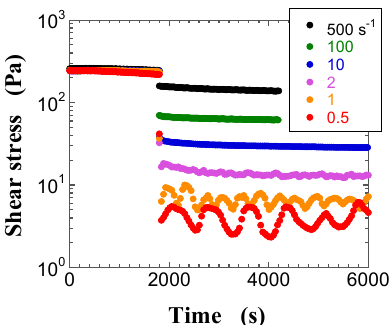
Figure 4. Plots of the transient shear stress for the precipitated silica (PS) suspension at φ = 0.030 at the shear rates of 0.5 s − 1 (filled red circle), 1 s − 1 (filled orange circle), 2 s − 1 (filled purple circle), 10 s − 1 (filled blue circle), 100 s − 1 (filled green circle), and 500 s − 1 (filled black circle) as a function of time.